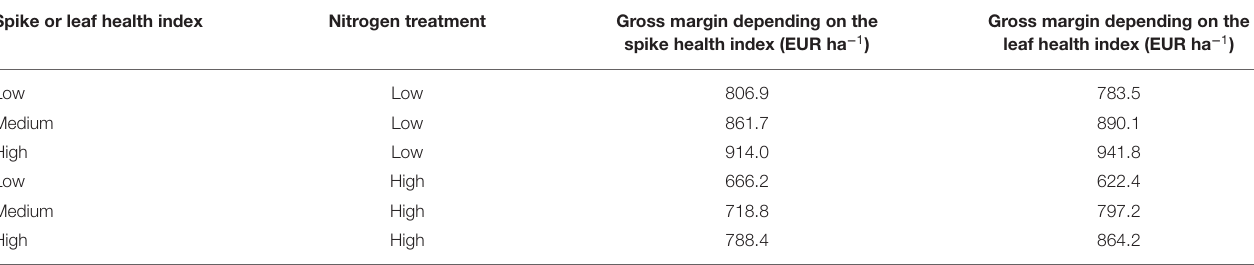
TABLE 6 | Average gross margin according to the spike and leaf health index, as well as the nitrogen treatment for all varieties without fungicide application. Spike or leaf health